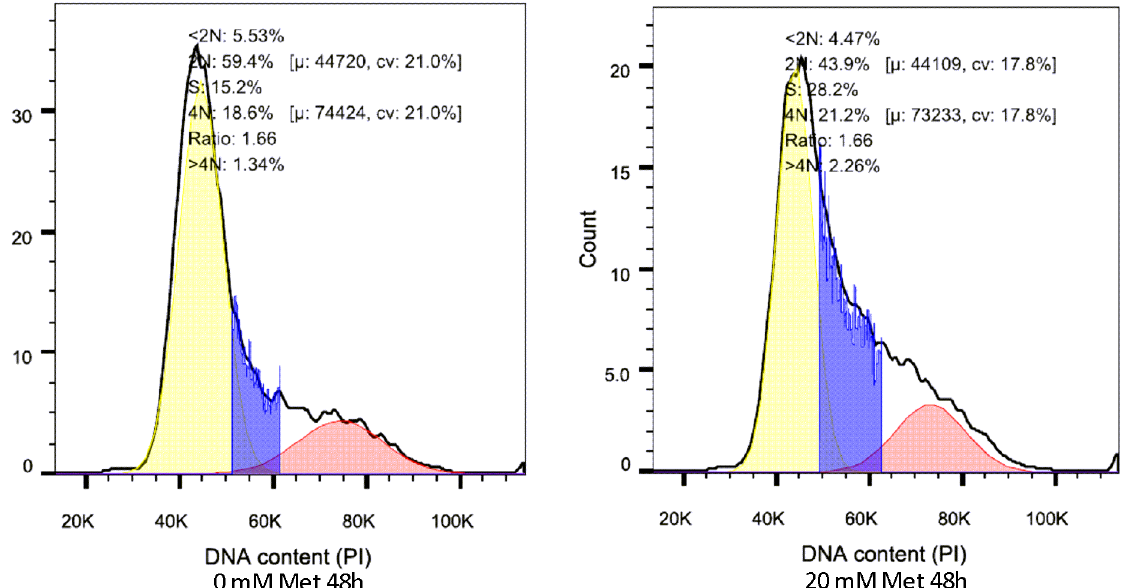
Fig 3. Metformin blocks cell cycle progression. Human HaCaT cells were grown in plate (5 x 105 cells). After 24h the culture medium was replaced with fresh culture medium containing 0 mM or 20 mM metformin for an additional 48h. Cell cycle progression in HaCaT cells was assessed by flow cytometry by analyzing PI fluorescence in slow acquisition and with doublet discrimination, 50000 events were acquired. Histogram showing cell cycle HaCaT with 0 mM and 20 mM of metformin, in the cells treated with 20 mM can be seen an increase in the proportion of cells which are in transition from G0/G1 to S phase. Histograms depicted above are representative of at least three independent experiments, which showed similar results.